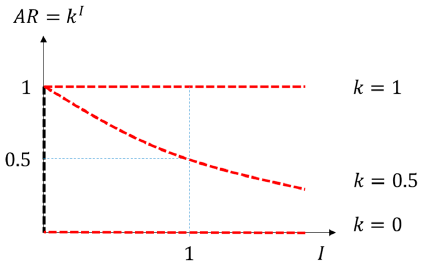
Figure 7. Relation between the Adaptation Ratio and the GPS point gap. If the Adaptation Coefficient k equals 1, AR remains 1 regardless of the point gap. If k equals 0, AR becomes 0 for all nonzero values of the point gap.